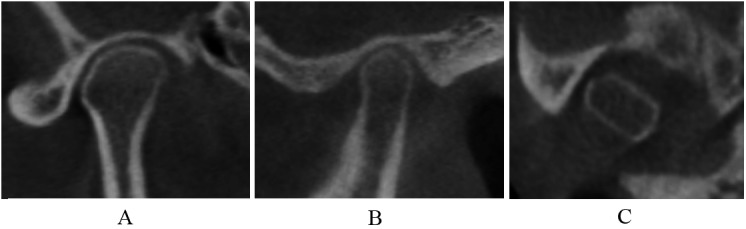
Condylar hypoplasia in coronal (A), sagittal (B), and axial (C) images.